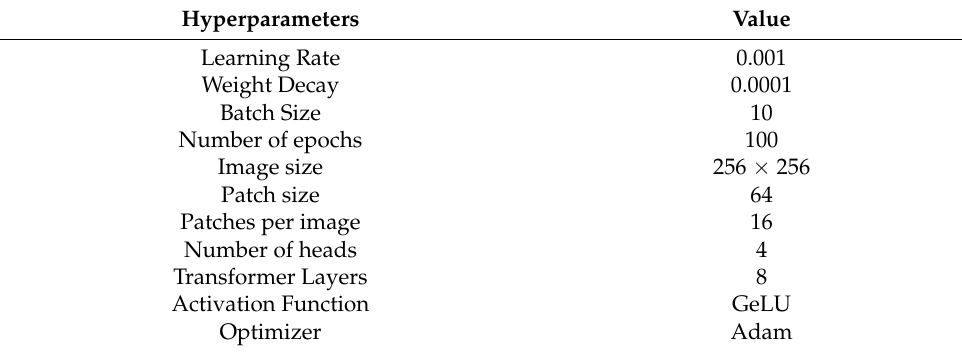
Table 2. Hyperparameters of the Vision Transformer model.